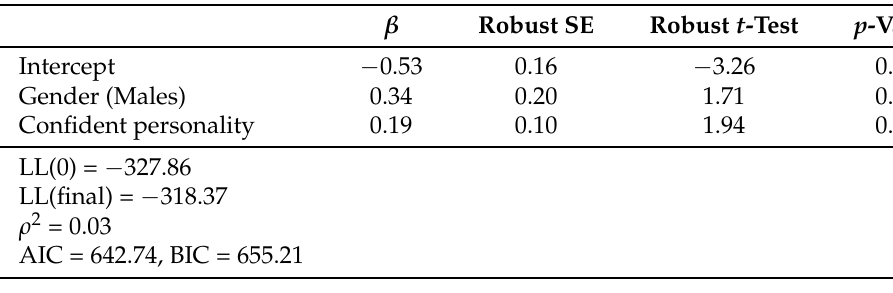
Table 5. Hyperloop immediate adoption model results (binary logit model).